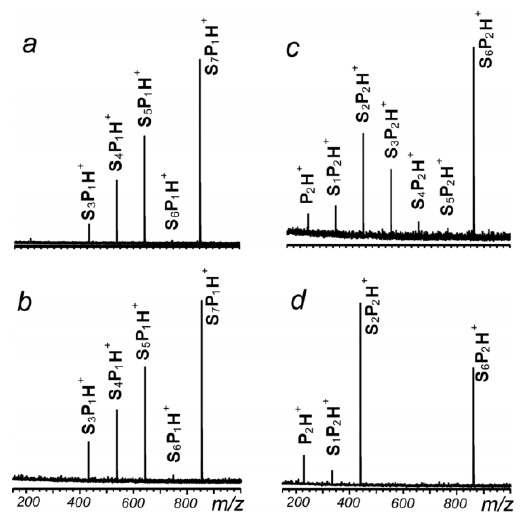
Figure 5. IRMPD mass spectra of ( a ) [ L -Ser7 + L -Pro1]H + ; ( b ) [ L -Ser7 + D -Pro1]H + ; ( c ) [ L -Ser6 + L -Pro2]H + and ( d ) [ L -Ser7 + D -Pro2]H + [40]. Reprinted with permission from RSC.